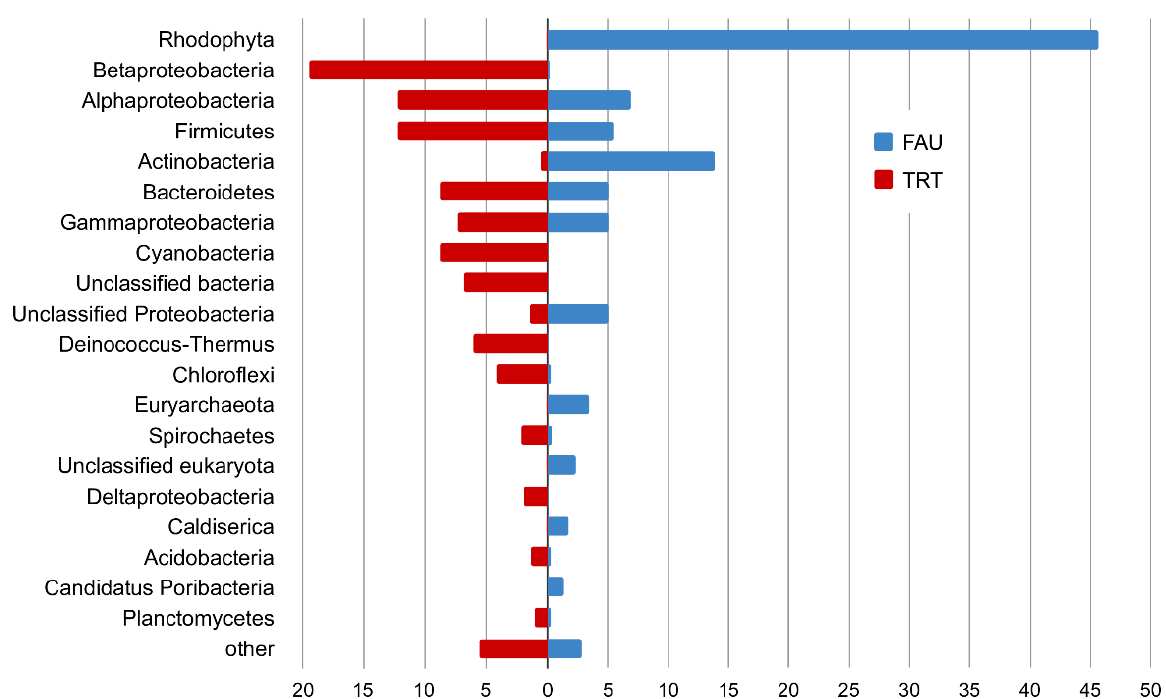
Figure 8. The plot comparing phyla abundance (classes in the case of Proteobacteria) between FAU and TRT (%).